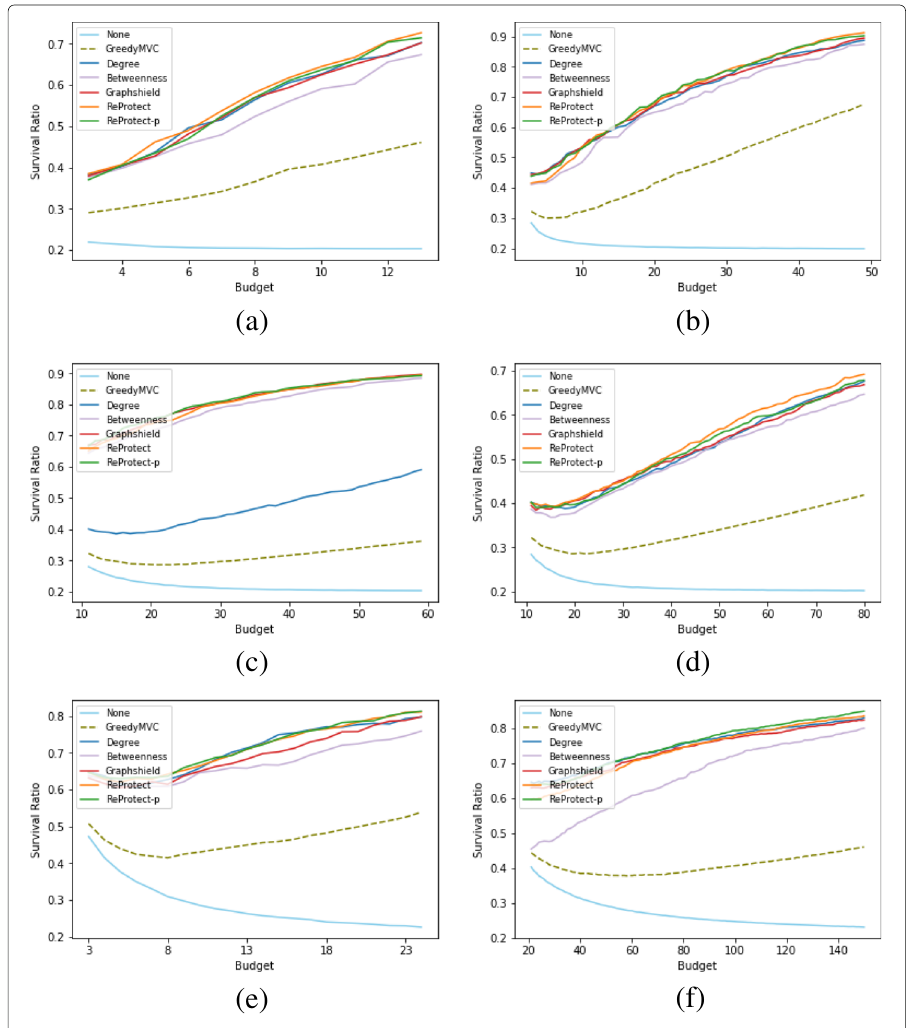
Fig. 7 Effectiveness evaluation on SIR epidemic model. Both of our proposed methods (green and orange colored lines) outperform the other competitors. Higher is better. a Hospital. b Hypertext 2009. c PrimarySchool. d Highschool 2013. e Infectious. f Email